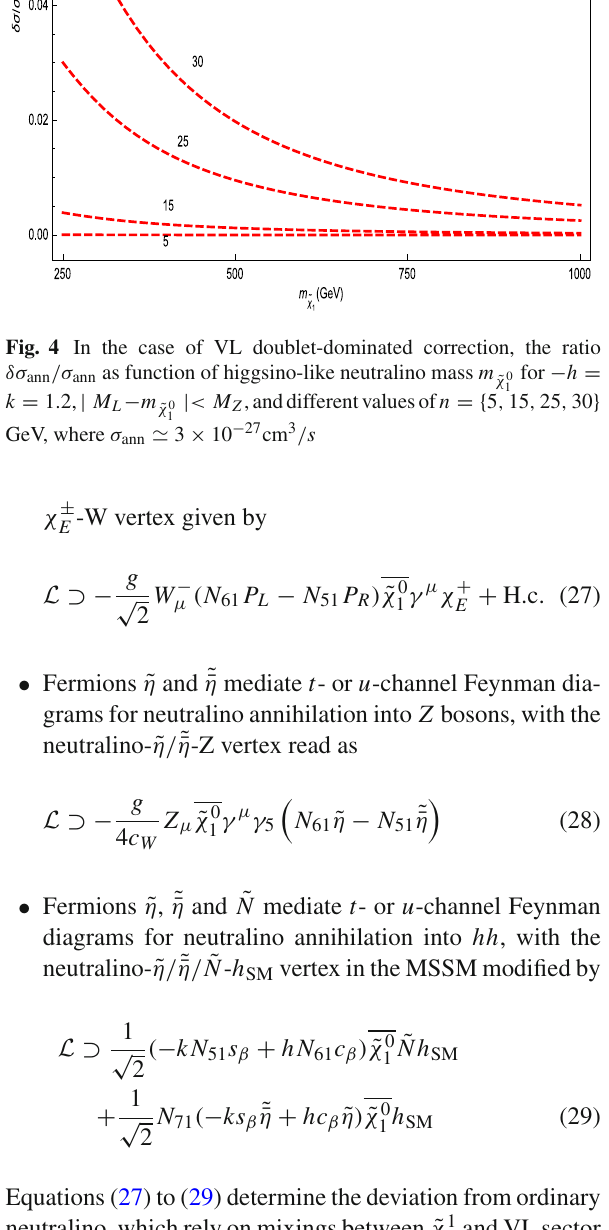
Table 3 The SM backgrounds for productions of VL electroweak fermion pairs at the LHC, where E miss momentum